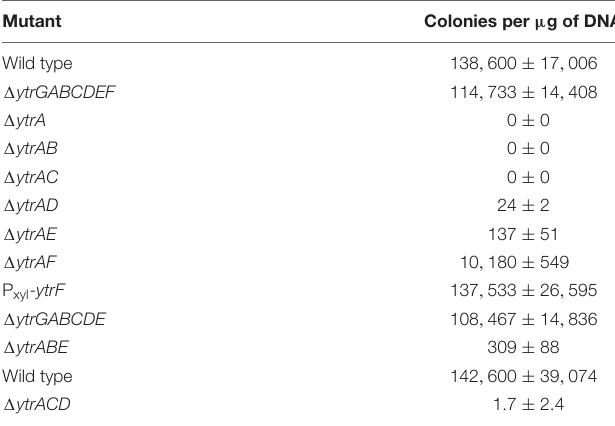
TABLE 4 | Effect of gene deletions in the ytrGABCDEF operon on the development of genetic competence a . Mutant Colonies per µ g of DNA Wild